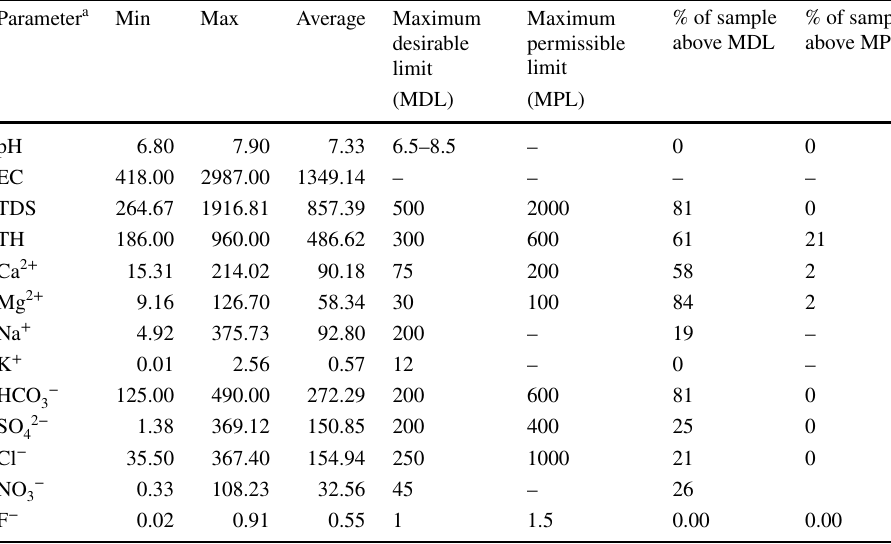
of physicochemical analysis of groundwater